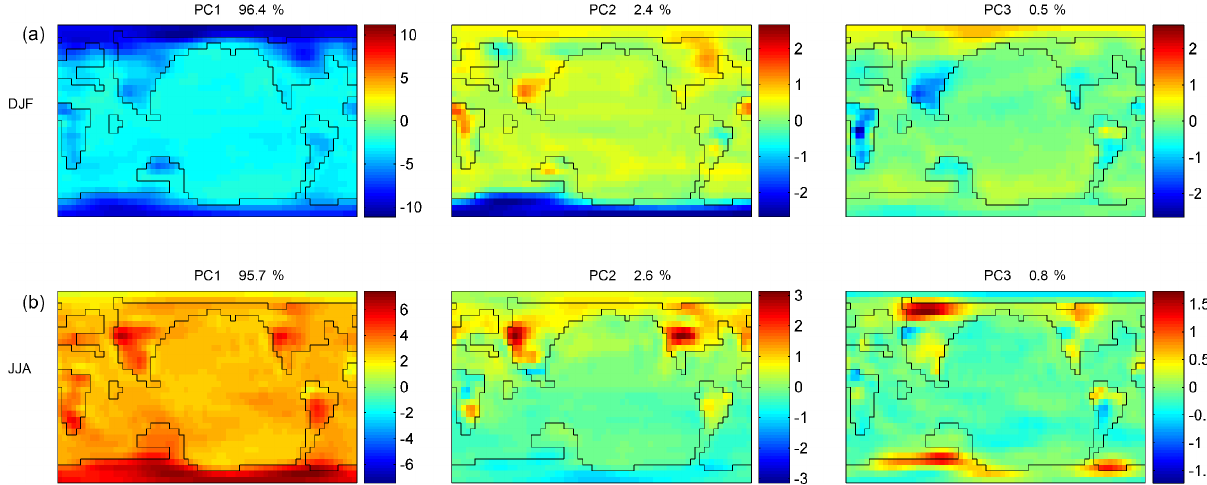
Figure 8. The first three principal components of DJF temperature (a) and JJA temperature (b) . Percentages of variance explained by each principal component are shown above each plot.